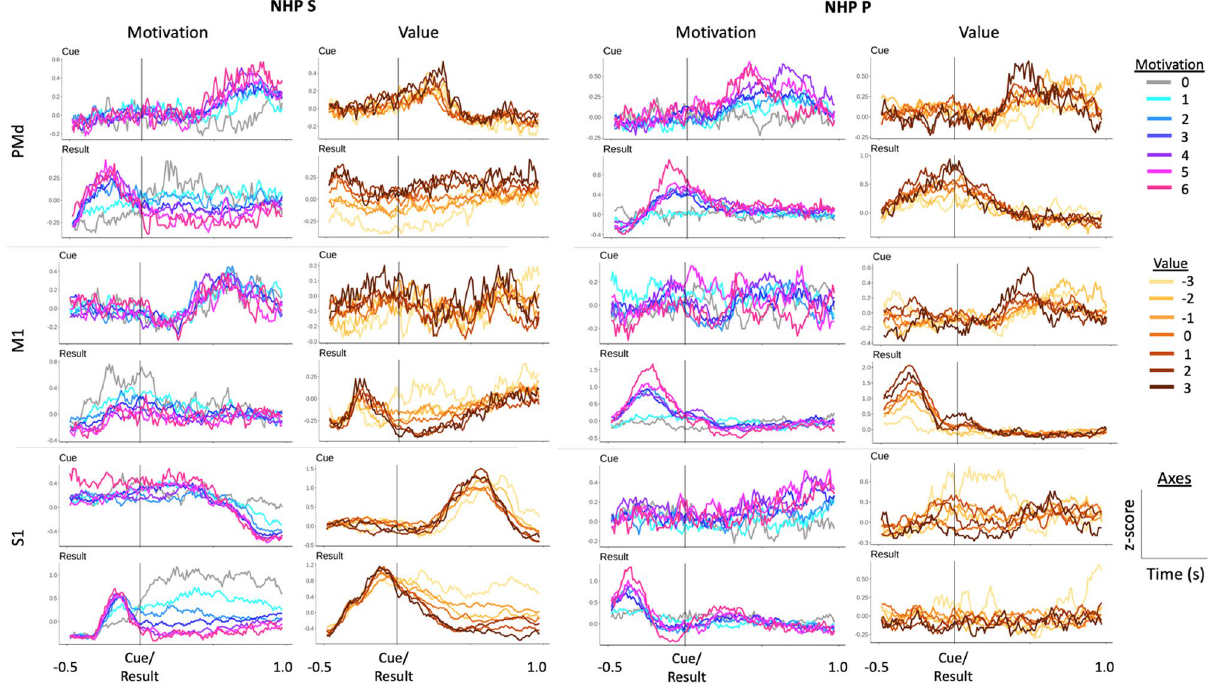
column are from an individual and distinct unit. Here we show units that qualitatively represent either valence- like or motivational-intensity-like response patterns. Units were binned and z-score normalized throughout a session. This normalized firing rate was then averaged for each valence level, defined as the reward level minus the punishment level for a given trial, or each motivational intensity level, defined as the reward level plus the punishment level for a given trial. Individual units demonstrated a range of responses following cue presentation and before and after